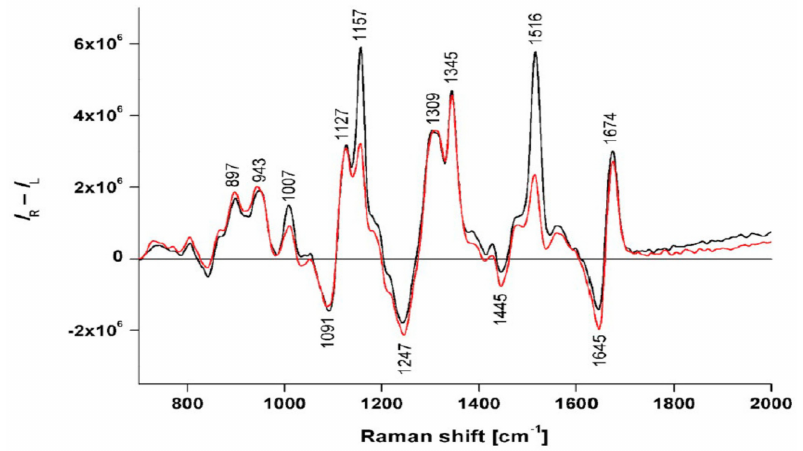
Figure 17. Averaged ROA spectra of blood plasma patients with Alzheimers disease (red) and non-demented elderly controls (black). Reprinted with permission from ref. [113].